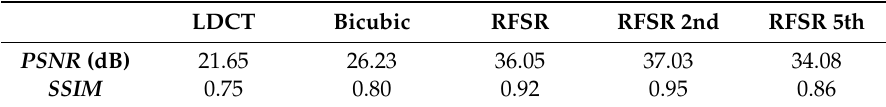
Table 3. Comparison of relevant